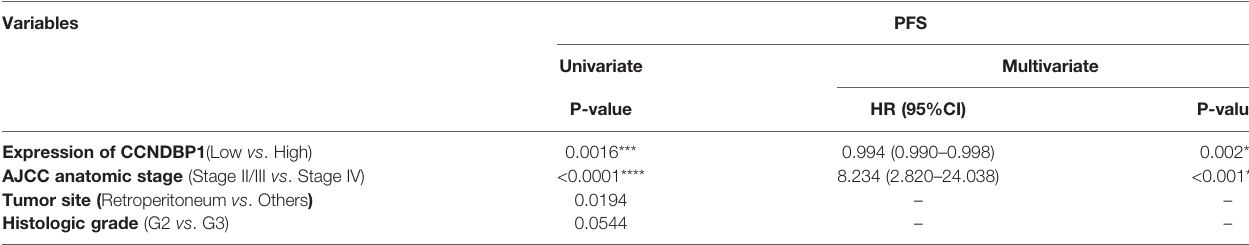
TABLE 2 | Univariate and multivariate analysis of the progression-free survival of patients.